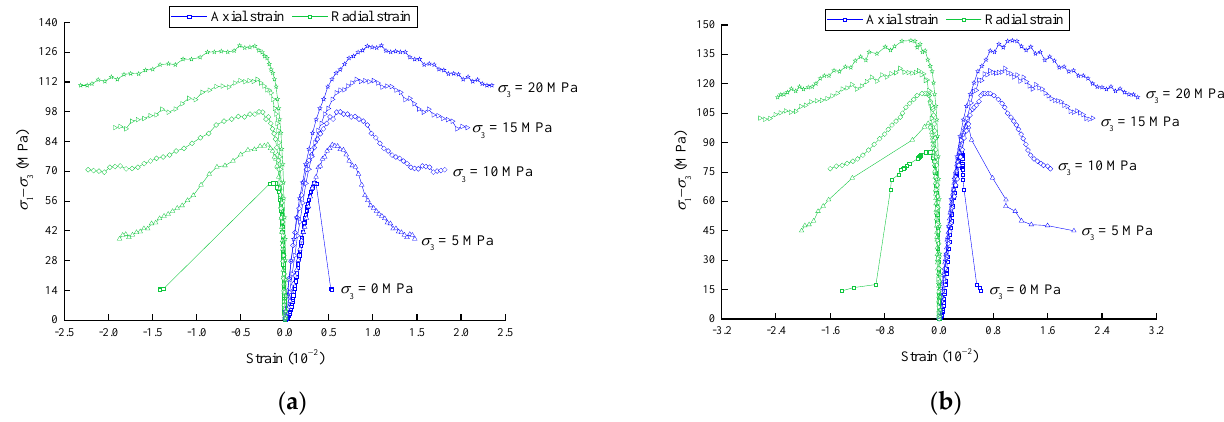
Figure 2. Conventional triaxial stress–strain curves of high-strength concrete. ( a ) C60 and ( b ) C70. According to the test results, the basic mechanical parameters of C60 and C70 high- strength concrete at different confining pressures are shown in Table 3. Table 3. Mechanical parameters of high-strength concrete (C60 and C70) at different confining pressures. σ 3